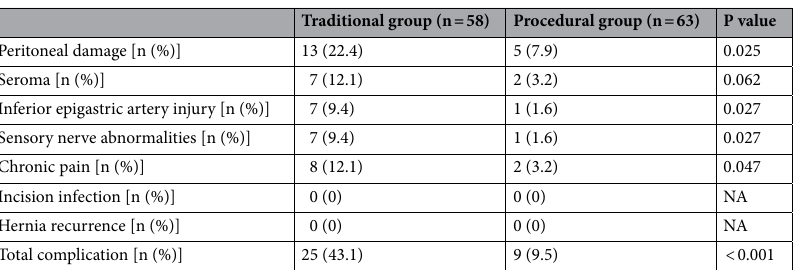
Table 3. Comparison of complications between the traditional group and the procedural group. NA not